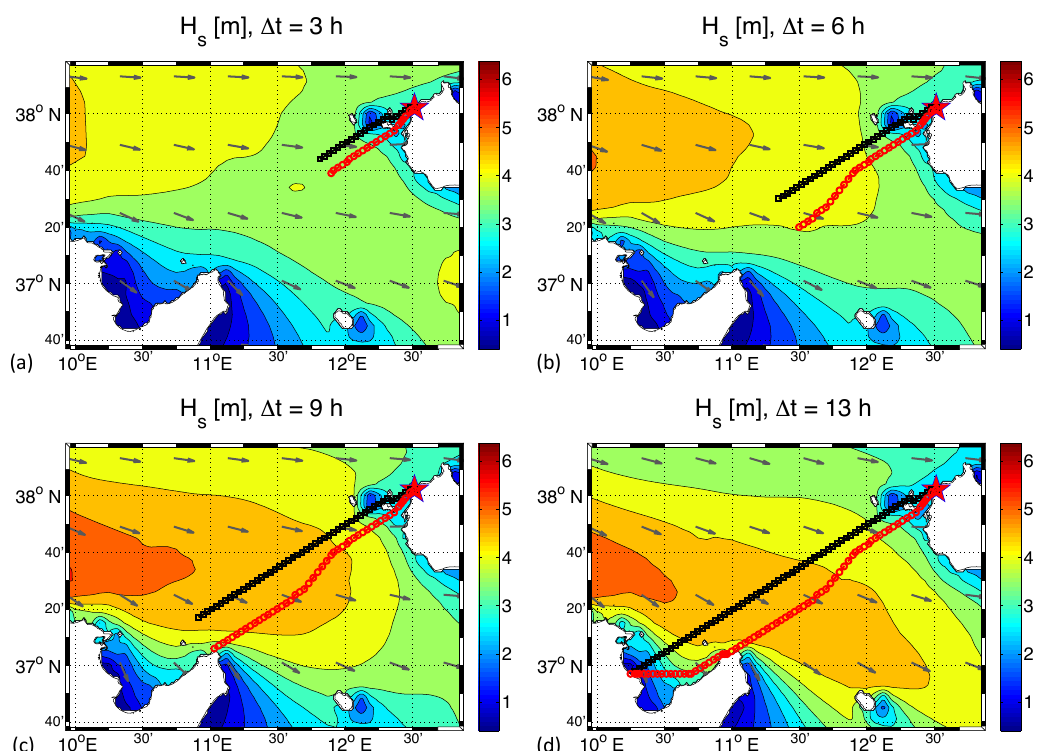
Figure 10. Case study #1. Geodetic (black markers) and optimal (red markers) route from Trapani (Italy) to Tunis (Tunisia) for vessel V1 of Table 5 and departure on 26 December 2013 at 21:00UTC. Panels (a–d) refer respectively to timesteps #4, 7, 10, 14 after departure. Significant wave height analysis fields H s are displayed with coloured shadings and wave directions are displayed with arrows. As seen in Table 11, in this case, the geodetic route takes longer than the optimal route to reach the destination (d) . Animation of the route is provided at http://dx.doi.org/10.5446/18087. Table 10. Cycloidal benchmark: length and duration of the three routes shown in Fig. 9. The free parameters in Eq. (50) are R and g 10 − 3 ms − 2 . Quantities in rows 2 and 5 refer to the numerical results using the VISIR-I grid. Quantities in rows 3 and 6 are errors = computed with respect to the values in the “Perfect cycloid” column of rows 2 and